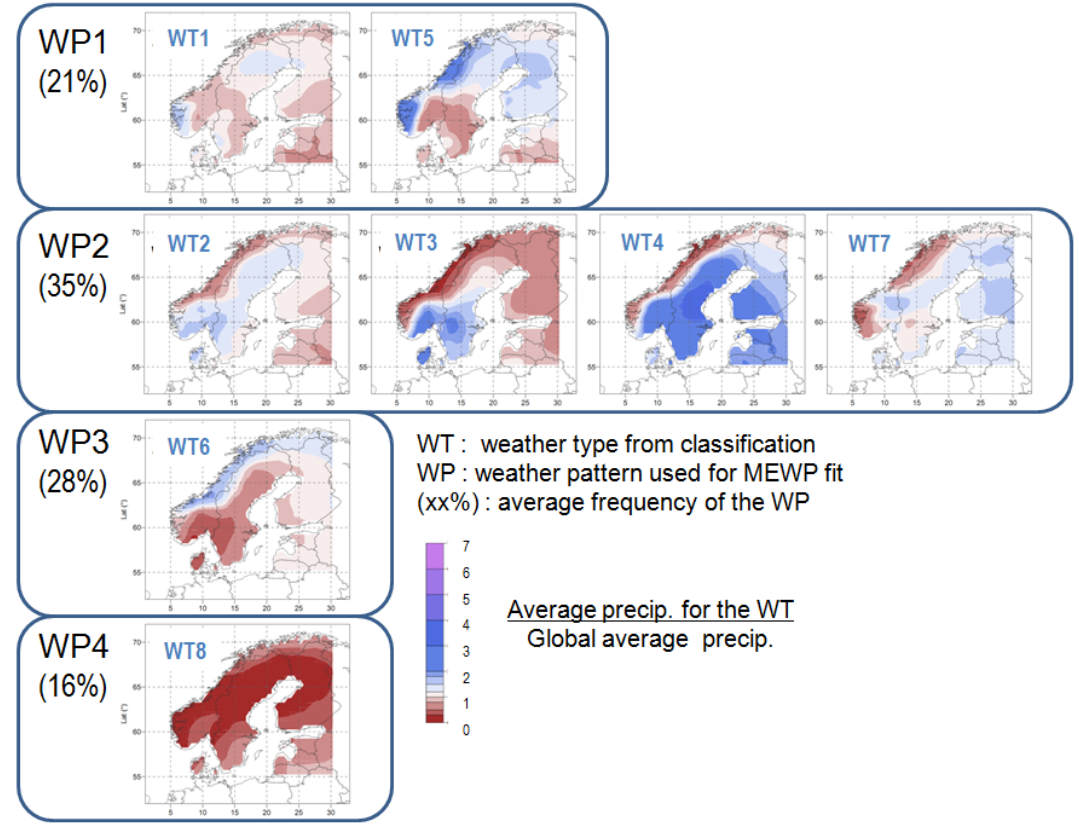
Figure 3. Weather pattern classification with four classes (denoted WT1 to WT4 above) and eight classes (WP1 to WP8 above). This is Fig. 5 of Lawrence et al. (2014). Case with four classes is obtained by combining the eight classes into four. The last class of each classification (respectively WT4 and WP8) represent dry